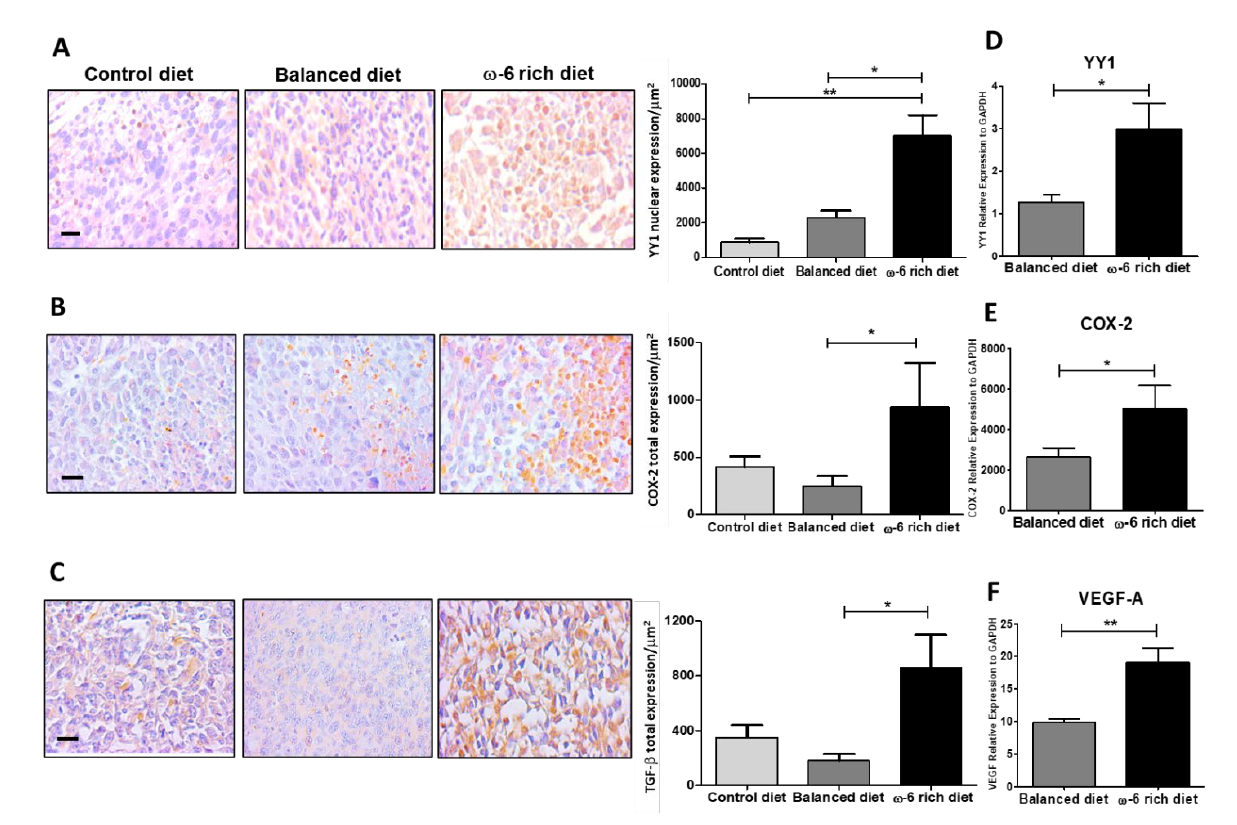
Figure 5. High intake of ω -6 PUFA induces the expression of aggressiveness markers. ( A ) Repre- sentative photomicrographs and analysis of YY1 expression (* p < 0.05 and ** p < 0.01). ( B ) COX-2 immunostaining, * p < 0.05. ( C ) TGF- β immunostaining (* p < 0.05) in the groups of mice fed with control diet, balanced diet, and diet rich in ω -6. Representative microphotographs of the expression of the different markers are shown on the left. On the right side, the quantification of the stains can be seen, the data represent the mean + SEM, n = 5. Scale bar: 20 μm. ( D ) Analysis of YY1, ( E ) COX-2, and ( F ) VEGF-A mRNA in the groups of mice fed a balanced diet and a diet rich in ω -6. Data represent mean + SEM, n = 5, * p < 0.05, ** p < 0.001. Results of three independent experiments are shown.